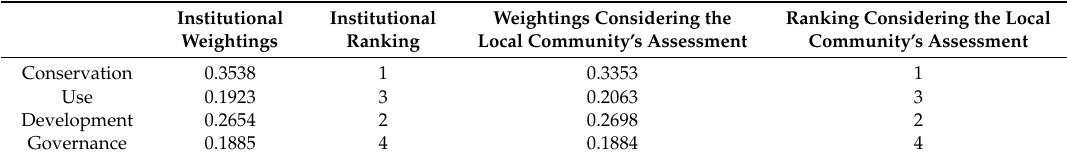
Table 2. Weightings and institutional ranking; weightings and ranking considering the local community’s assessments of the main management objectives.